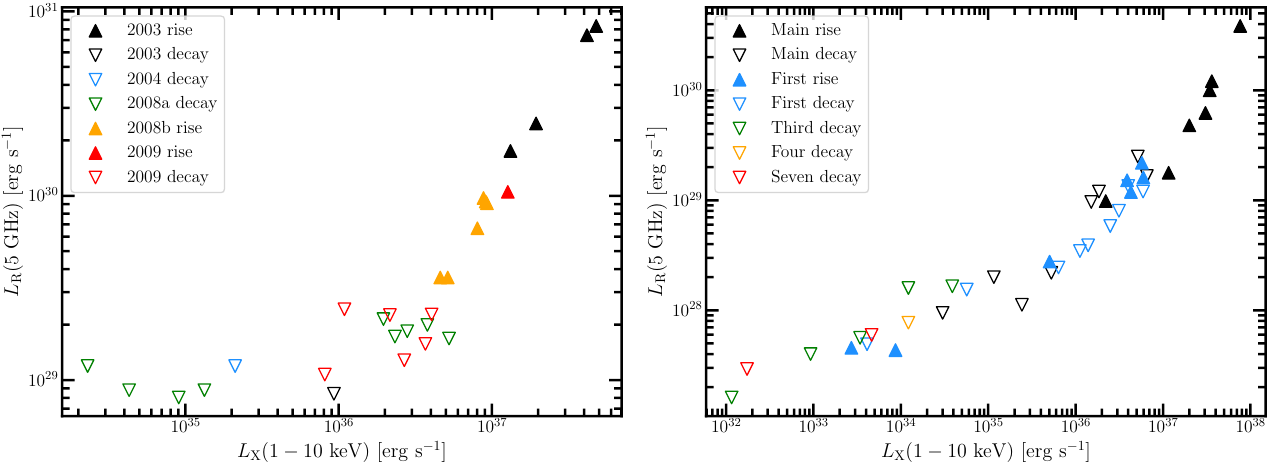
Figure 1. The respective radio/X-ray planes of the BHXBs H1743-322 and MAXI J1348-630 are shown in the left panel and right panel. In both panels, different triangles pointing upwards or downwards differentiate the outburst phase, i.e., filled triangles pointing upwards for the rise and open triangles pointing downwards for decay; the colors represent the different